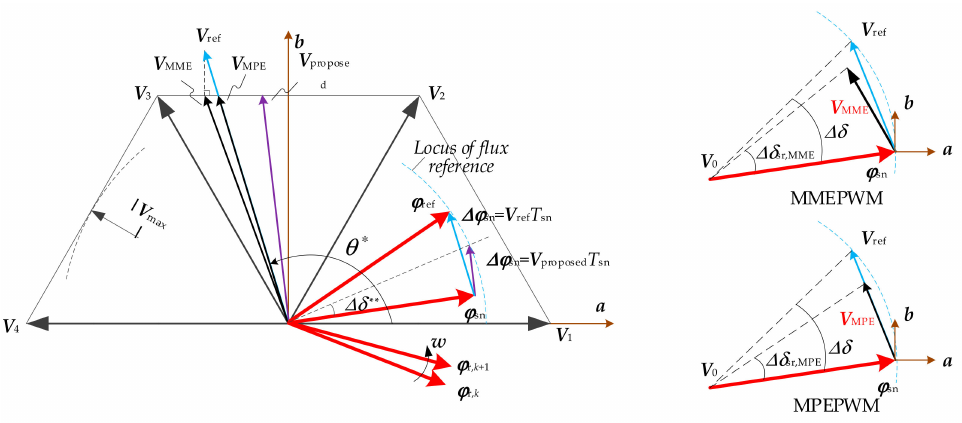
Figure 6. The correction algorithm of the incremental value of the load